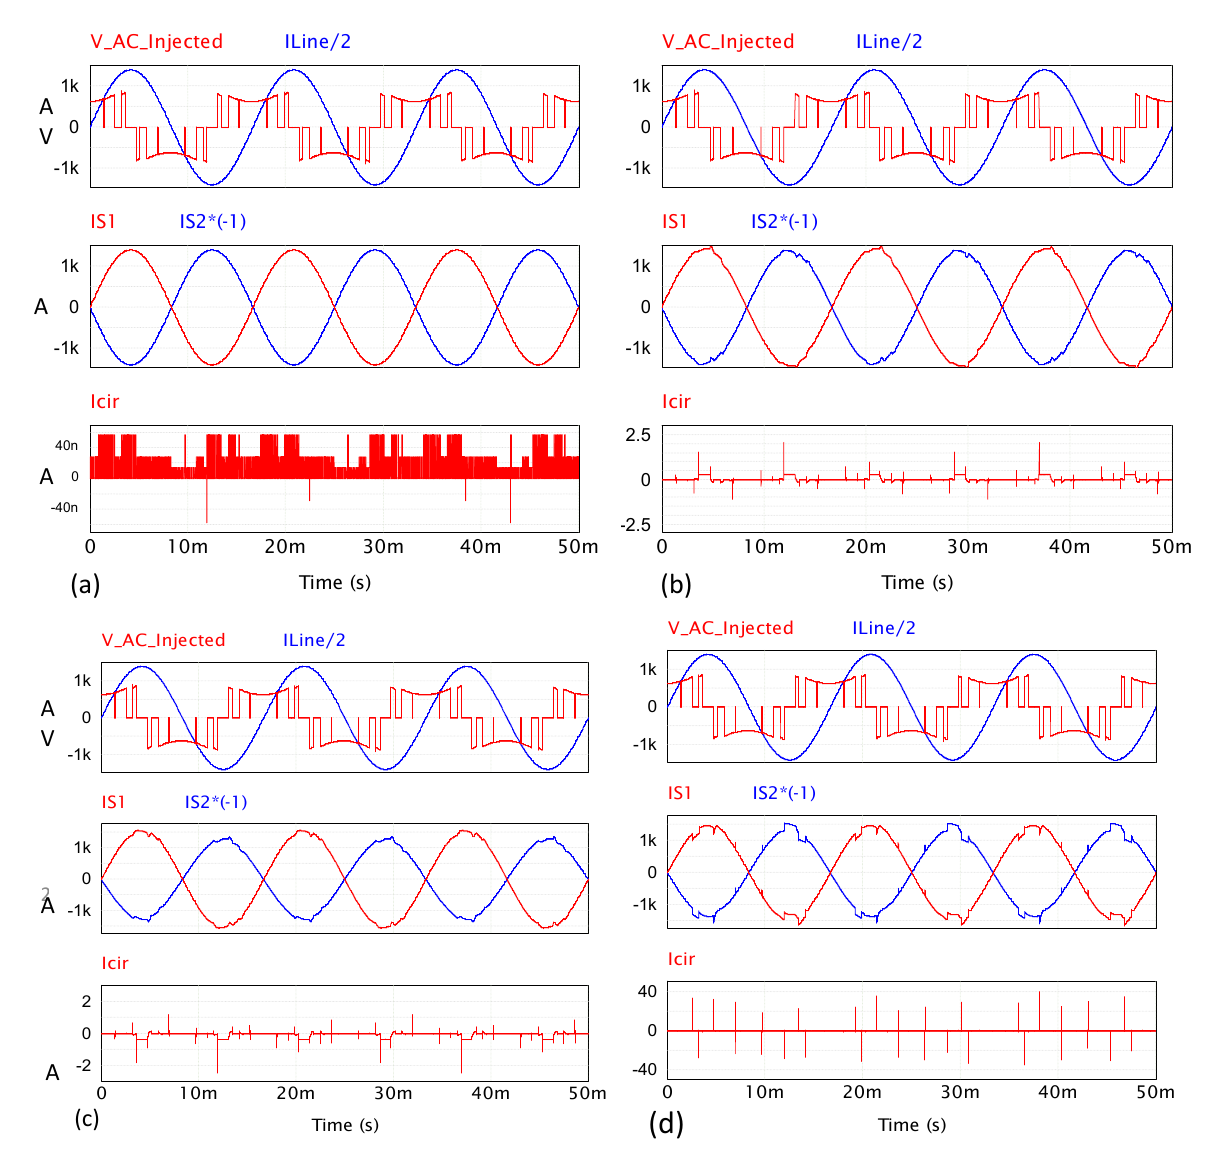
Figure 14. Outputs of the system with: ( a ) two identical converters; ( b ) Converter 2 with 20% higher impedance than converter 1; ( c ) 20% different capacitors’ banks; ( d ) 10% different capacitors’ bank and 1 us IGBTs’ time delay.